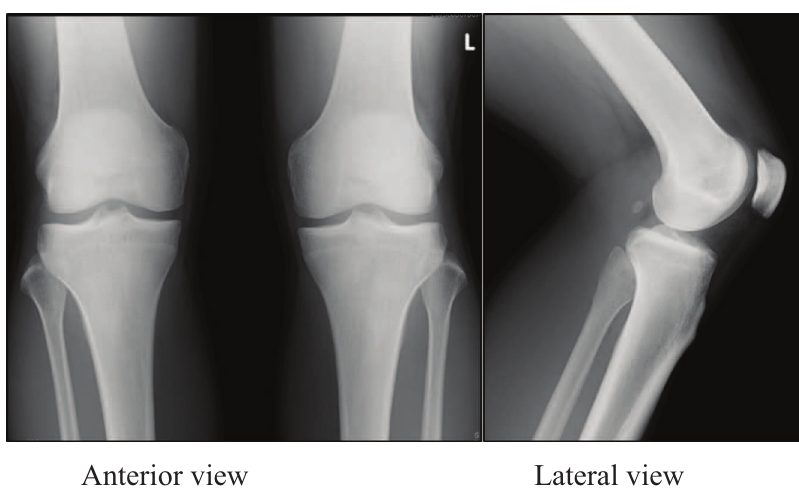
Figure 1. Plain X-ray images at the fi rst consultation. Inclination angle of proximal tibio fi bular joint was 26 (cid:1) (based on the measurement method of Ogden), showing an oblique type, with no notable articular degeneration of the proximal tibio fi bular joint.